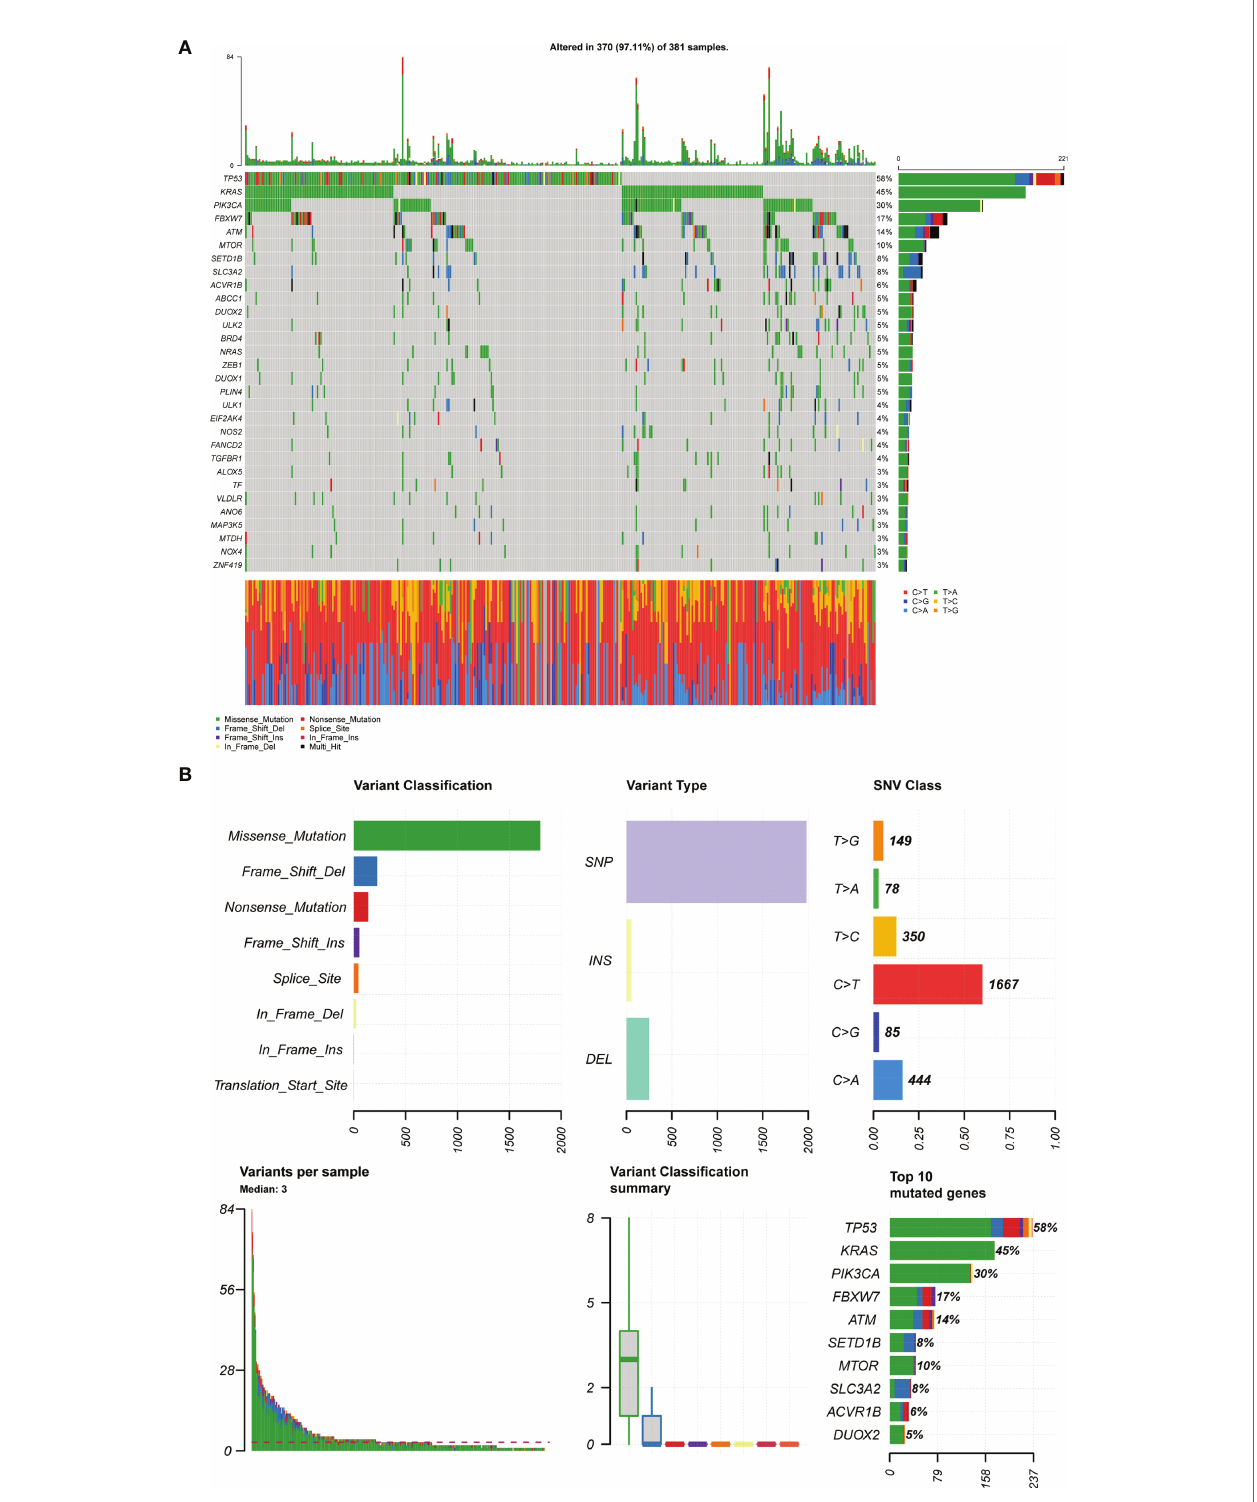
FIGURE 11 | TCGA-CRC mutation cohort. (A) The waterfall map depicts the frequently mutated FRGs (top 30) in CRC. The right panel shows mutation frequency, and genes are ordered by their mutation frequencies. The bottom panel presents different mutation types. (B) Overview of TGCA-CRC cohort FRGs mutations. Classi fi cation and frequency of mutation types (top left). Frequency of variant types (top middle). Frequency of SNV classes (top right). Tumor mutation burden in speci fi c samples (bottom left and middle). The top 10 mutated genes in CRC (bottom